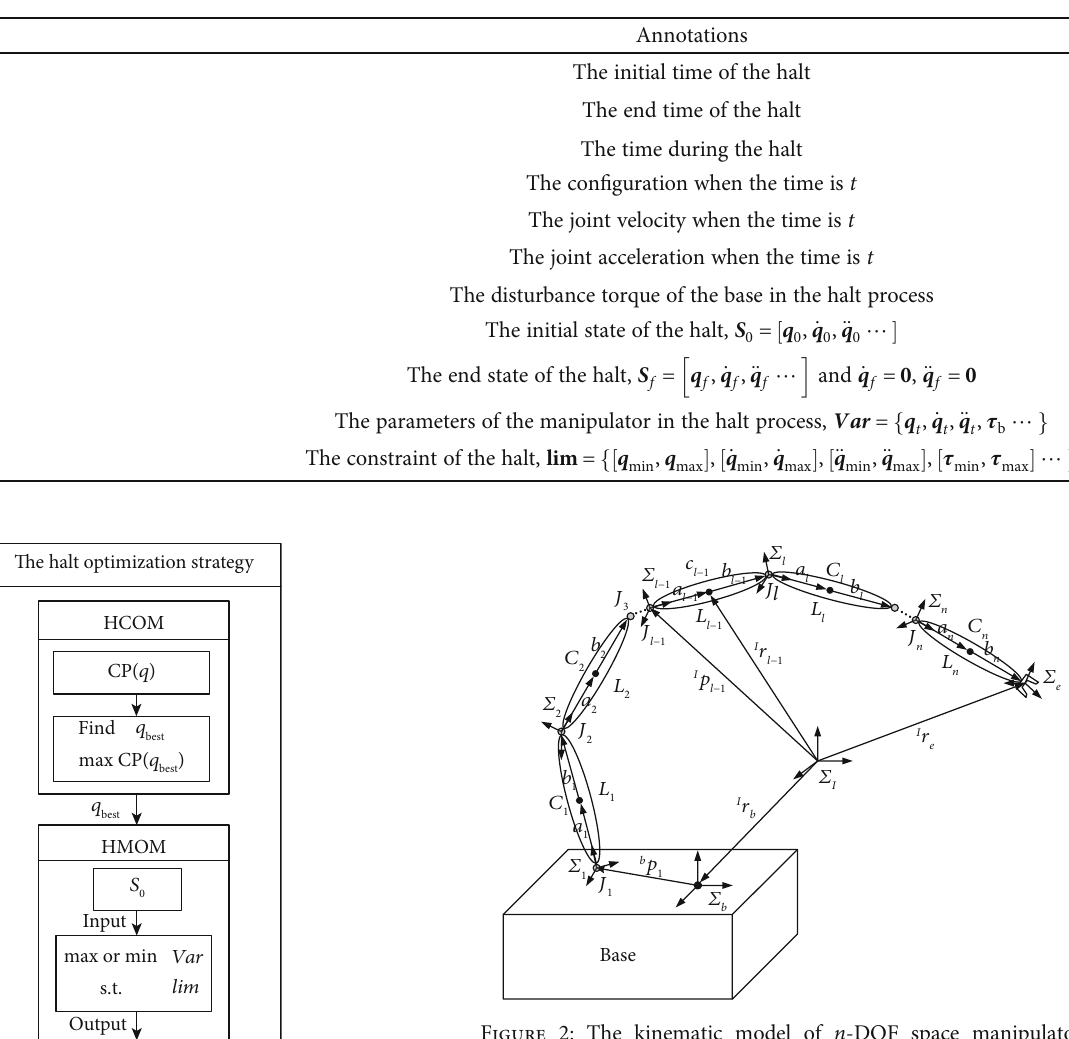
Table 1: Symbols annotations of the halt.